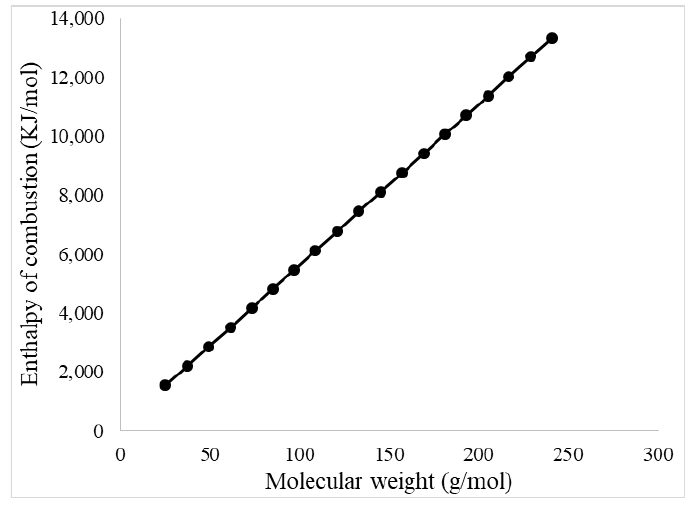
Figure 11. The effect of molecular weight of n-paraffins on enthalpy of combustion .